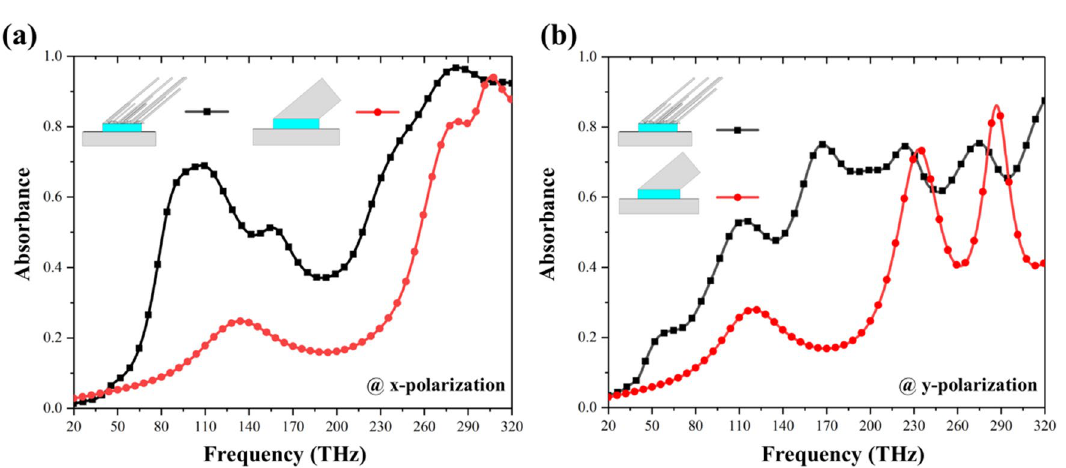
Figure 5. Absorbance of MOFS and the planar MPAs under normal incidence at ( a ) x- and ( b ) y-polarization, respectively. Absorbance are larger for MOFS MPA at both polarization, which could be attributed to different sizes and gap distance among the oblique flat sheets, thus resulting in different resonance conditions and coupling strength among